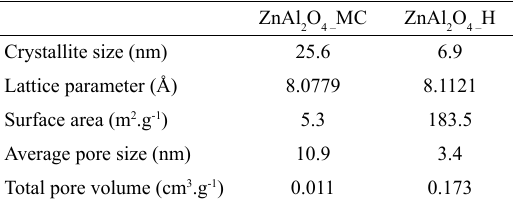
O powders. 2 4 O 2 4